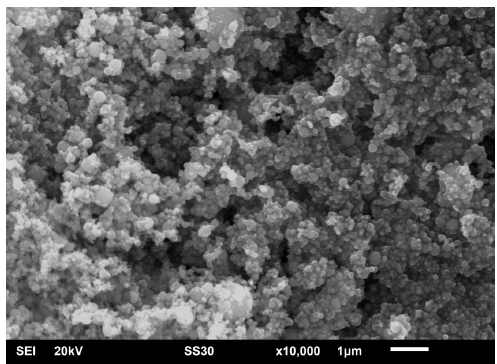
Figure 1. Microscopic images of iron oxide